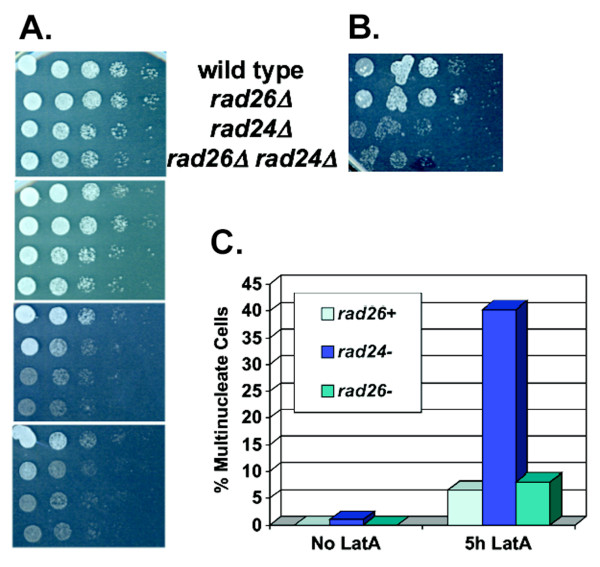
The rad26Δ and rad24Δ alleles may cause TBZ-sensitivity by a pathway that is independent of the cytokinesis checkpoint. A. The rad26Δ rad24Δ strain did not display an additive phenotype on TBZ medium. Cultures of wild type (TE236), rad26Δ (TE257), rad24Δ (TE465) and rad26Δ rad24Δ (TW1235) were serially diluted and manually spotted onto YE5S and YE5S + 8, 14 and 16 μg/ml TBZ. Pictures were taken after 3 days of growth at 30°C. B. rad24Δ, but not rad26Δ, was sensitive to LatA. Cultures were spotted onto YE5S plates + 0.5 μM LatA. C. The cytokinesis checkpoint of rad26Δ cells was intact. Liquid YE5S cultures of wild type (TE236), rad26Δ (TE257) and rad24Δ (TE465) were left untreated or treated with 0.2 μM LatA for 5 hours, fixed with paraformaldehyde and stained with DAPI.